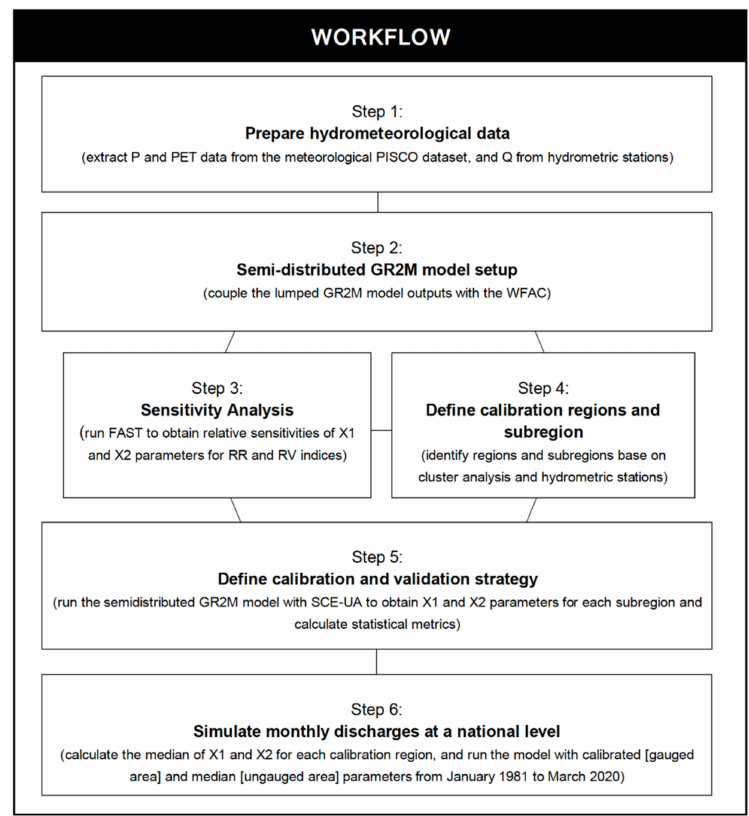
Figure 2. Methodological framework. Where: P = precipitation, PET = Potential Evapotran- spiration, Q = Discharge, WFAC = Weighted Flow Accumulation, FAST = Fourier Amplitude Test, RR = Rainfall-Runoff Index, RV = Runoff Variability Index, and SCE-UA = Shuffle Complex Evolutionary